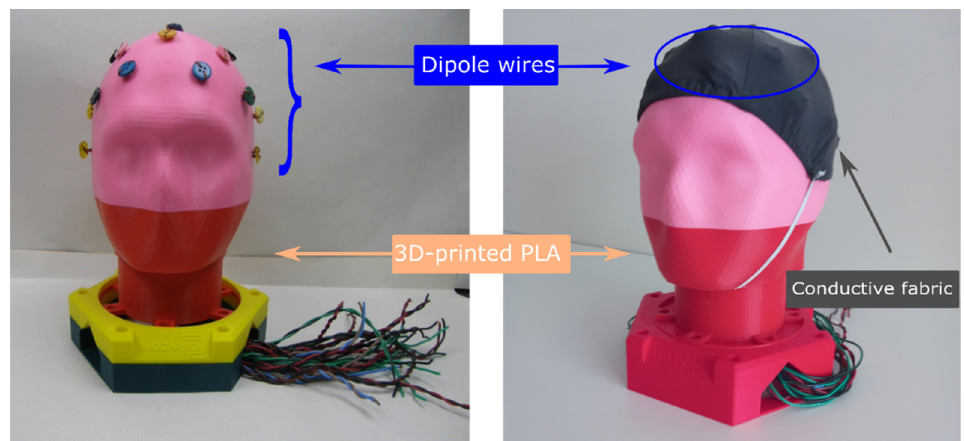
Figure 8. Textile-based head phantom [12], under CC by 4.0.